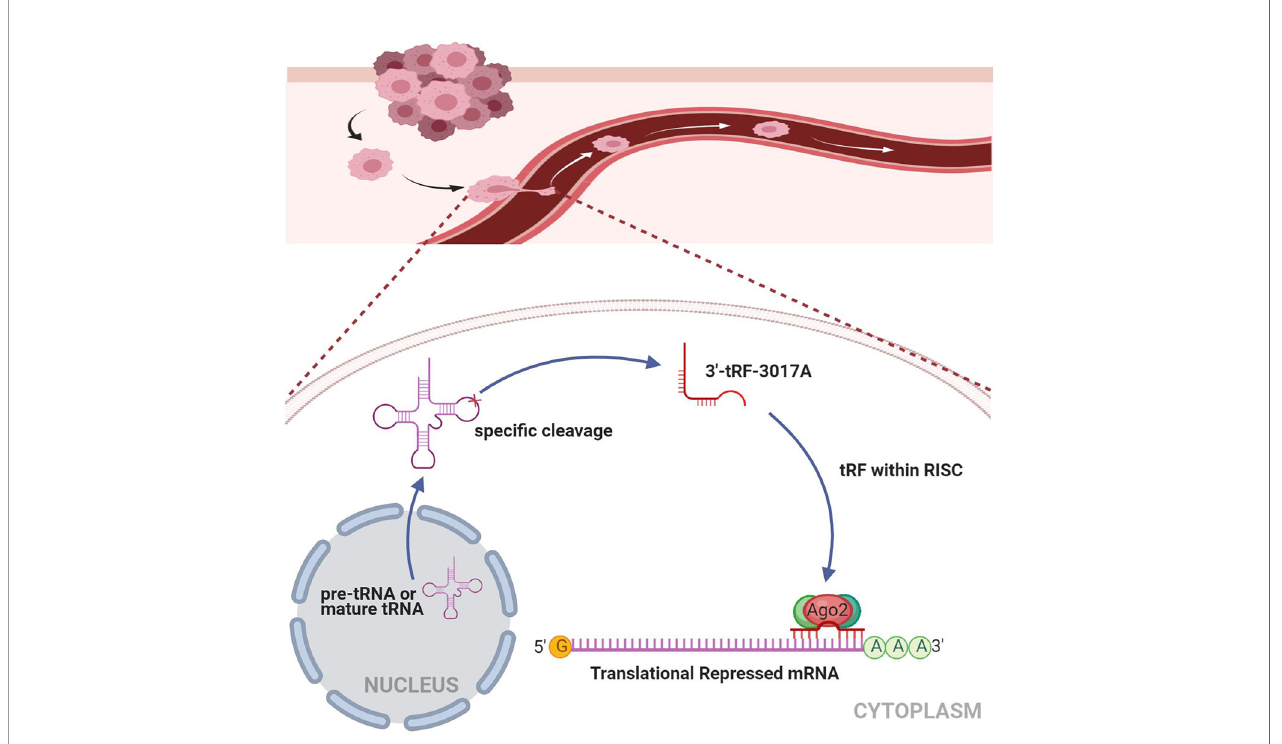
FIGURE 7 | Working model illustrating the mechanism in which tRF-3017A may promote GC cell migration and invasion by targeting NELL2. RISC, RNA-induced silencing